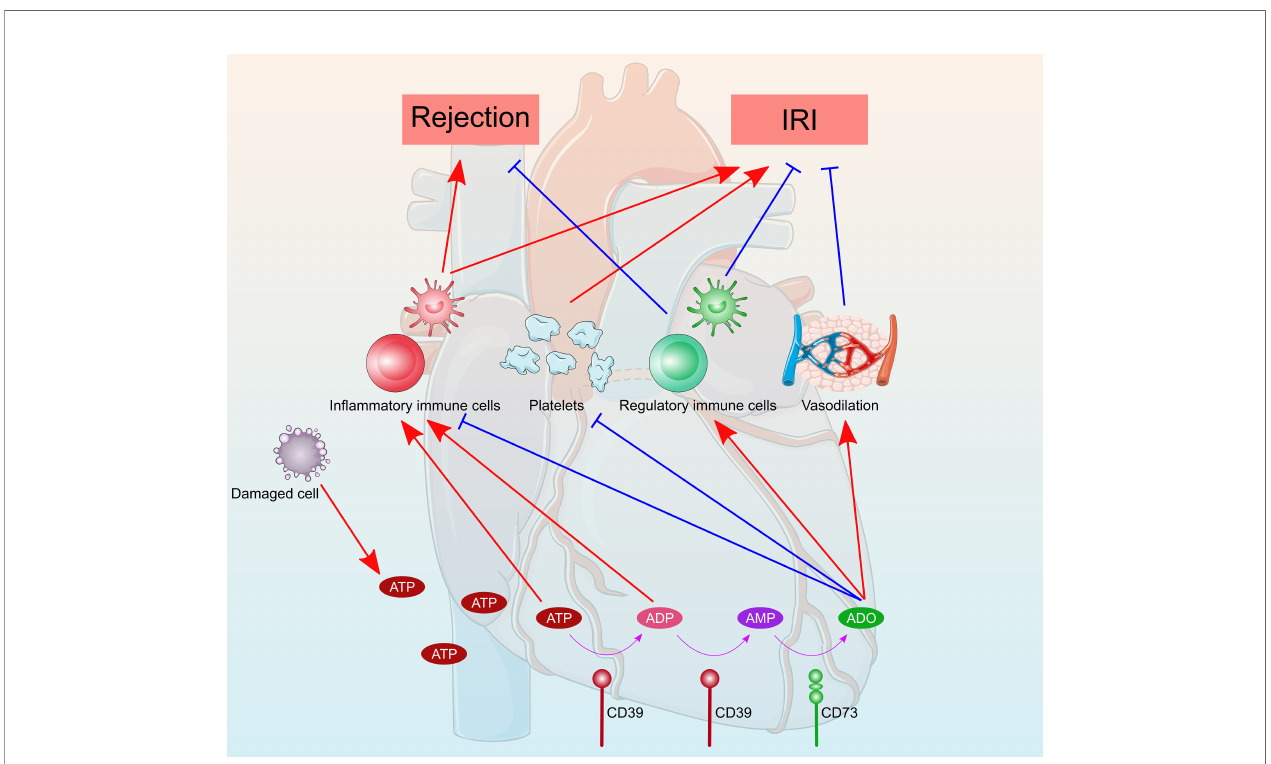
FIGURE 3 | Schematic diagram of the role of purinergic signaling in heart transplantation. ATP were released from damaged cells during the transplantation process. ATP were converted into ADP and AMP by CD39 and then catalyzed to adenosine by CD73. Extracellular ATP and ADP promote in fl ammatory responses and exacerbate detrimental rejection and cardiac ischemia reperfusion injury. Whereas, adenosine generally has anti-in fl ammatory and immunosuppressive properties, which protect the heart from rejection and ischemia reperfusion injury. Furthermore, the antiplatelet and vasodilatory effects of adenosine attenuate heart rejection and ischemia reperfusion